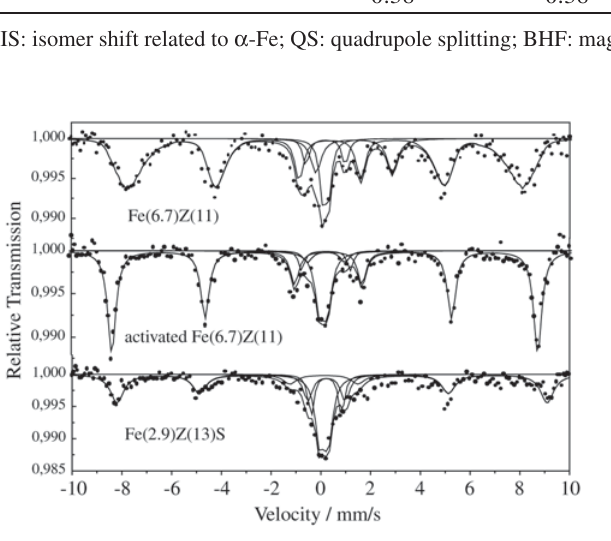
Figure 8. Mössbauer spectra of Fe/ZSM-5 catalysts obtained at -269